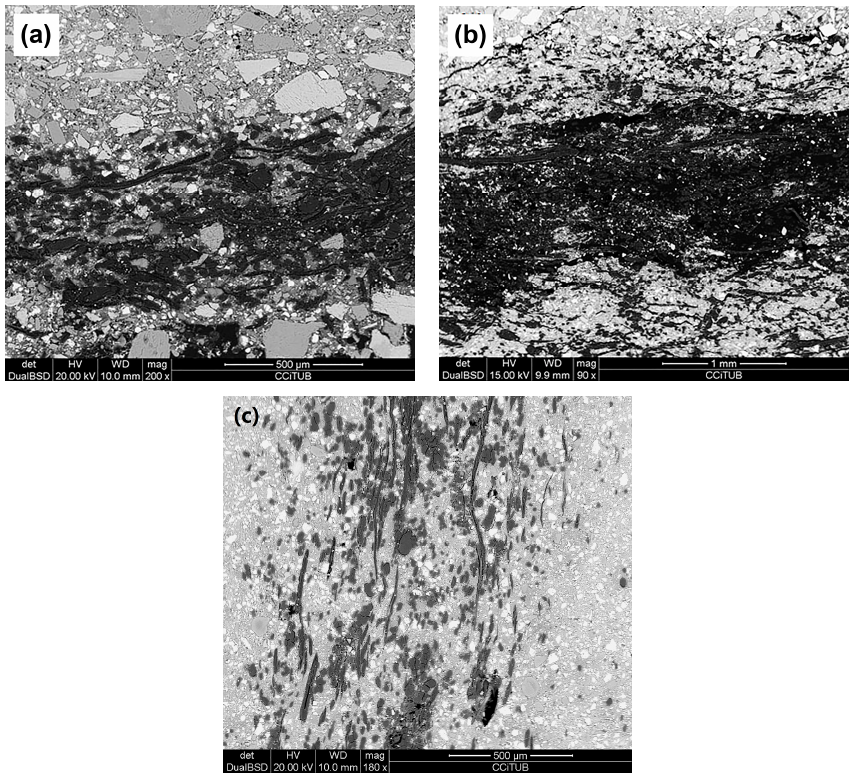
Figure 1. BSE–SEM images of the cement composites: ( a ) with sand; ( b ) with a nonwoven of 9 mm thickness and 680 g/m 2 ; ( c ) with a 2 mm thickness and 275 g/m 2 nonwoven.